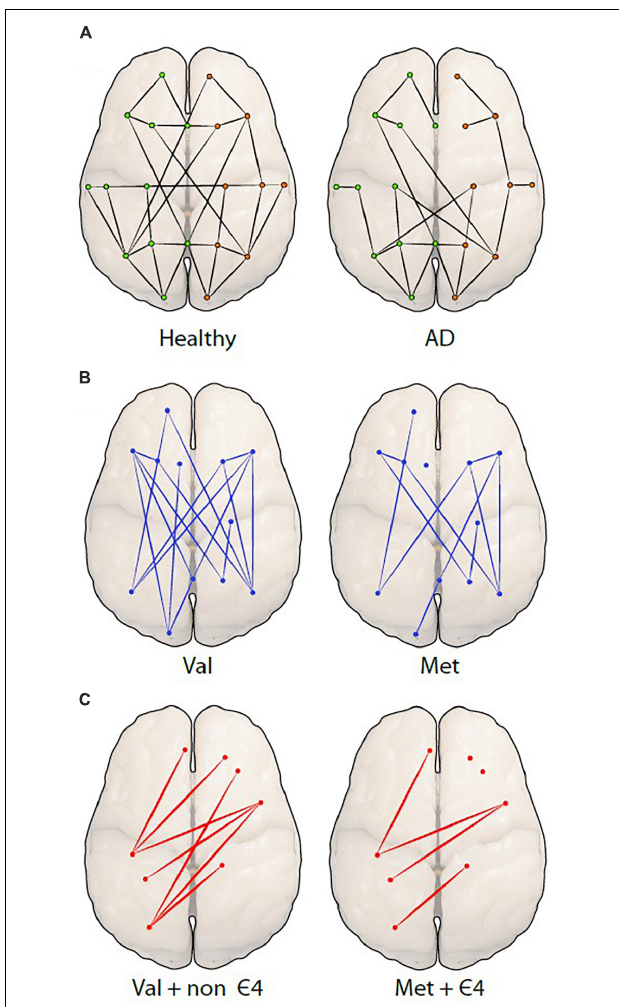
FIGURE 3 | Differences among network organizations are shown using a graph theoretical approach. (A) A graph of a healthy person (left) is compared to a person with Alzheimer’s disease (AD; right), showing fewer connections (edges) between the spatially distant brain regions (nodes or dots) in AD. The green (left) and orange (right) dots represent hemispheres. The next two figures are hypothetical figures of the BDNF Val66Met polymorphism (B) , in which the connections are noticeably decreased in Met carriers. The last figure represents the carriage of both (C) , BDNF and APOE displaying a distinct reduction of edges and nodes in